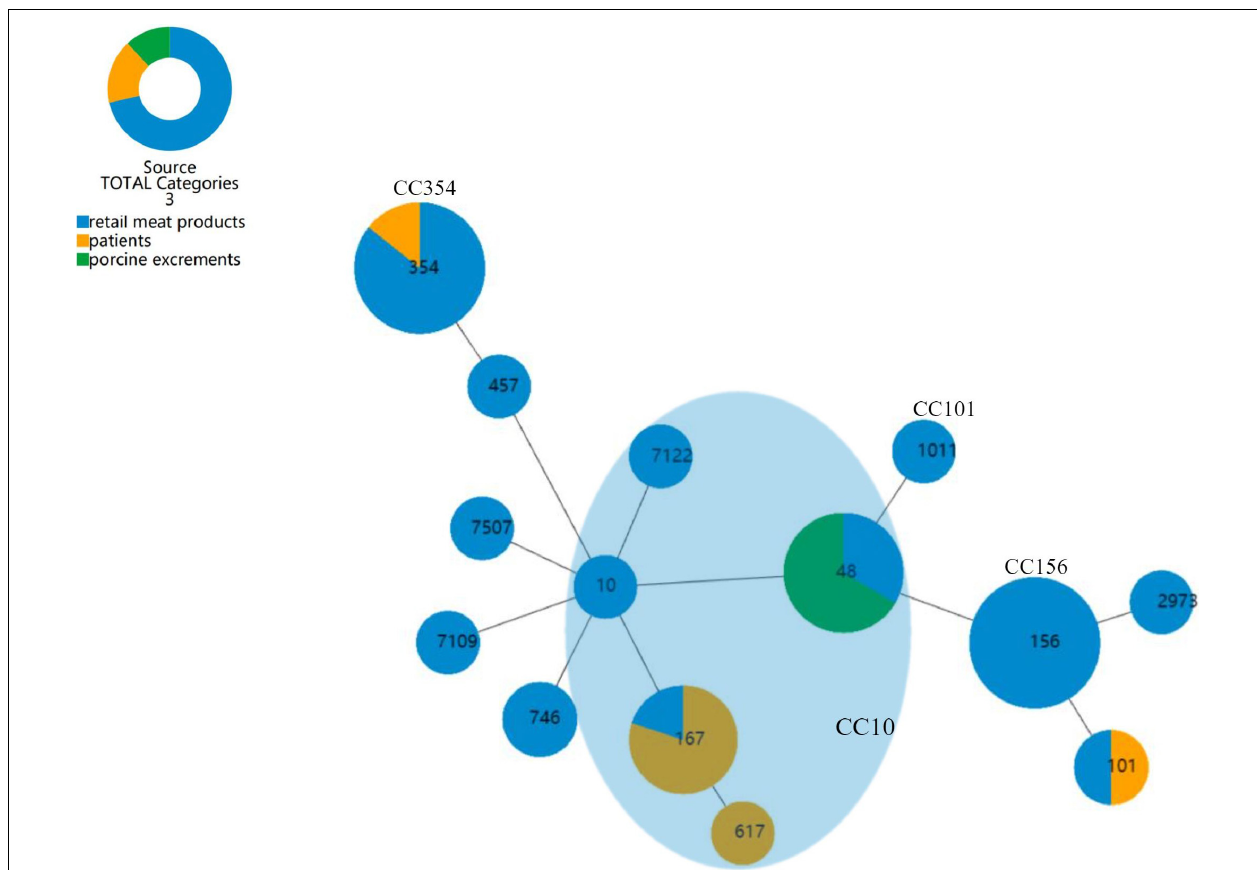
FIGURE 3 | goeBURST full MST analysis of 14 STs of E. coli . Each circle represents an ST, and the size of the circle reflects the frequency of each ST in the dataset; the number of different alleles is presented as STs, and the line between each circle is presented as distance labels (label edges with level value). CC represents a unique clonal complex. The shaded area represents the clonal complex